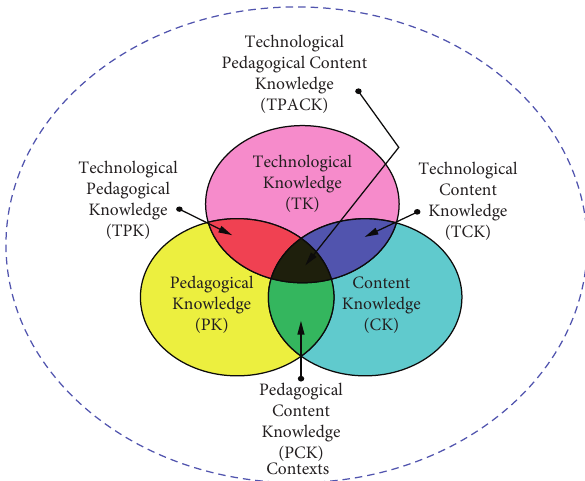
Figure 1: Technology pedagogy and content knowledge (TPACK)